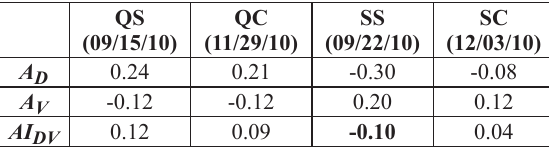
Duration asymmetry ( A D ), Velocity asymmetry ( A V ) and residual ( AI DV